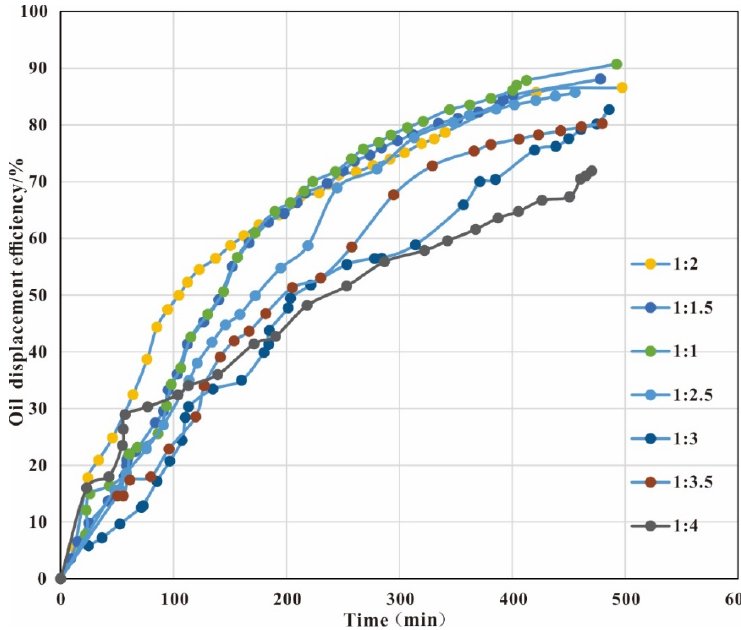
Figure 17. Oil displacement efficiency versus time.